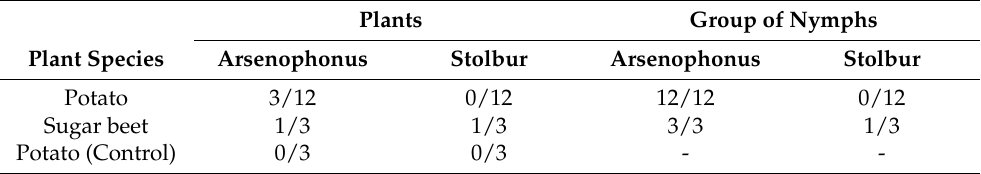
Table 2. Detection of Candidatus Arsenophonus phytopathogenicus (Arsenophonus) and Candidatus Phytoplasma solani (stolbur) in P. leporinus nymphs, as well as potato and sugar beet plants,